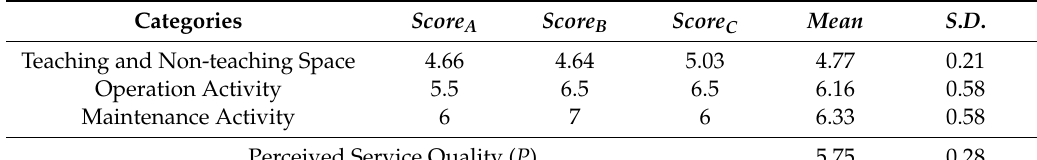
Table 4. Interview result for end-user’s perceived service quality (t =